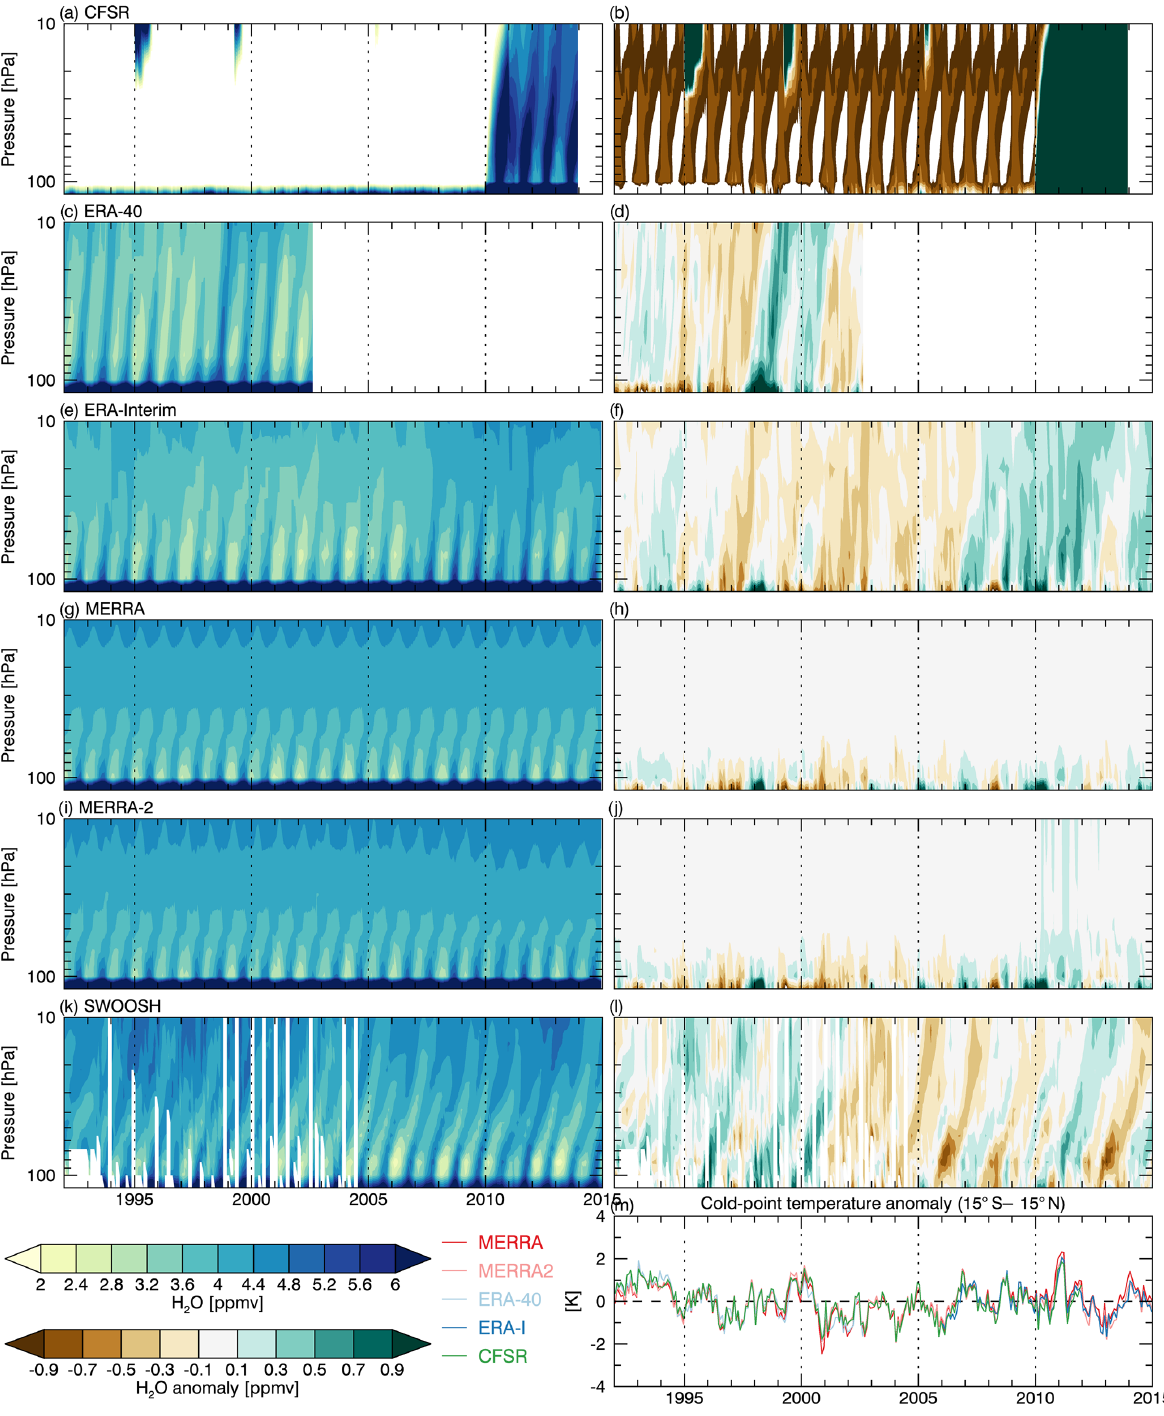
Figure 15. The tropical tape recorder signal as represented in reanalyses and the SWOOSH merged satellite product, defined as the height– time evolution of water vapor averaged over the 15 ◦ S–15 ◦ N tropical band. Both absolute values (a) and anomalies relative to the mean water vapor seasonal cycle at each level (b) are shown. Anomalies are computed separately for each data set. Monthly mean anomalies in tropical (15 ◦ S–15 ◦ N) cold-point tropopause temperatures calculated from 6h data on the native vertical resolution of each reanalysis model are shown for context